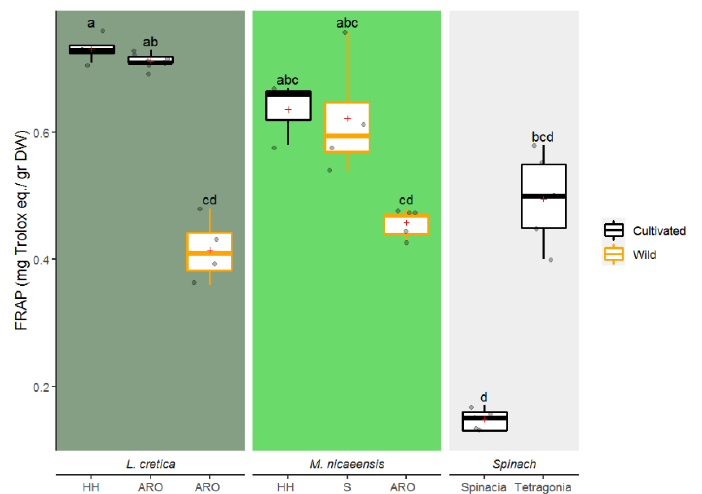
Figure 4. Antioxidative activity in leaves of two Malvaceae species and two spinach species. Different lowercase letters indicate significant differences between types of green leaves ( p < 0.05). Species names and abbreviations of locations are indicated in the lower line. HH = Havat Hanoi, ARO = research site at the Agricultural Research Organization; S = agricultural area near Sandala village, North Israel. Box plot color indicates “Cultivated” in an agricultural field, or “Wild”, grown wildly at field margins or in feral fields. Median and average are indicated as a horizontal line within the box plot and red cross, respectively, and gray dots denote results of single analyses.